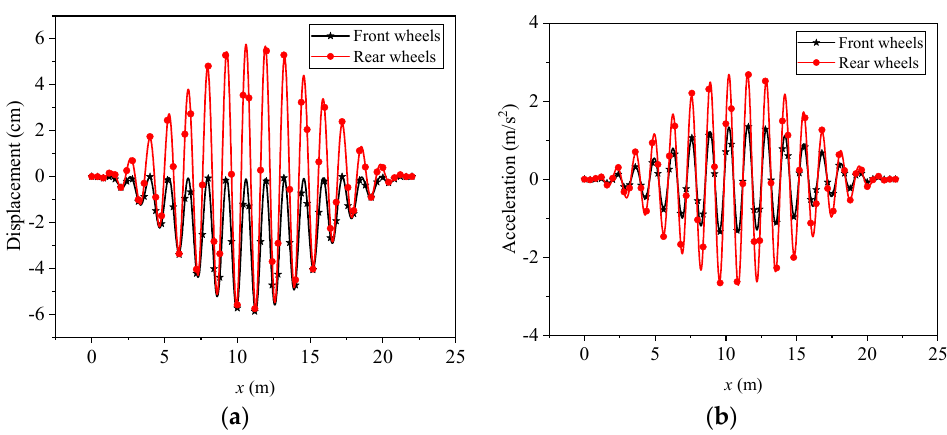
Figure 5. Net displacement ( a ) and vertical acceleration ( b ) of front and rear wheels 0 ≤ x ≤ ( b + c ). When x = 2 ns ( n ∈ N* ), the front and rear wheels are all located on uneven